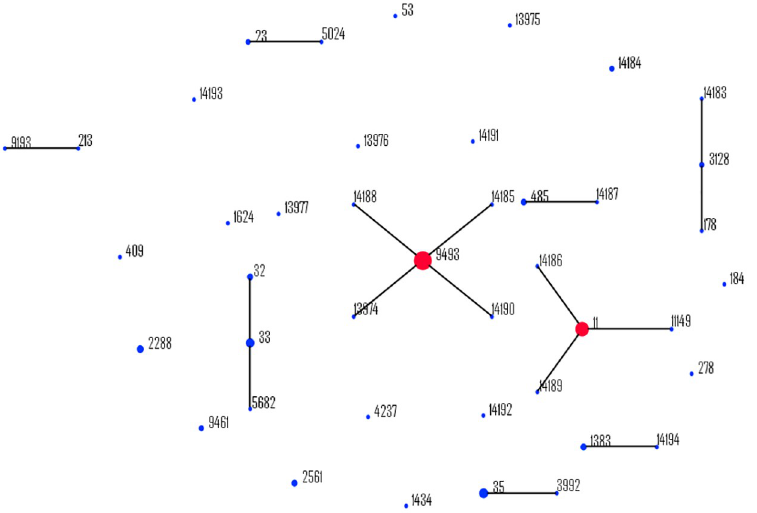
Fig 2. Distribution of sequence types (STs) among the clonal complexes of N . meningitidis . Genetic relatedness was determined by full eBURST analysis using MLST allelic profiles of seven housekeeping genes. STs that are linked by a line belong to the same cluster. Circle sizes are proportional to the number of isolates within the